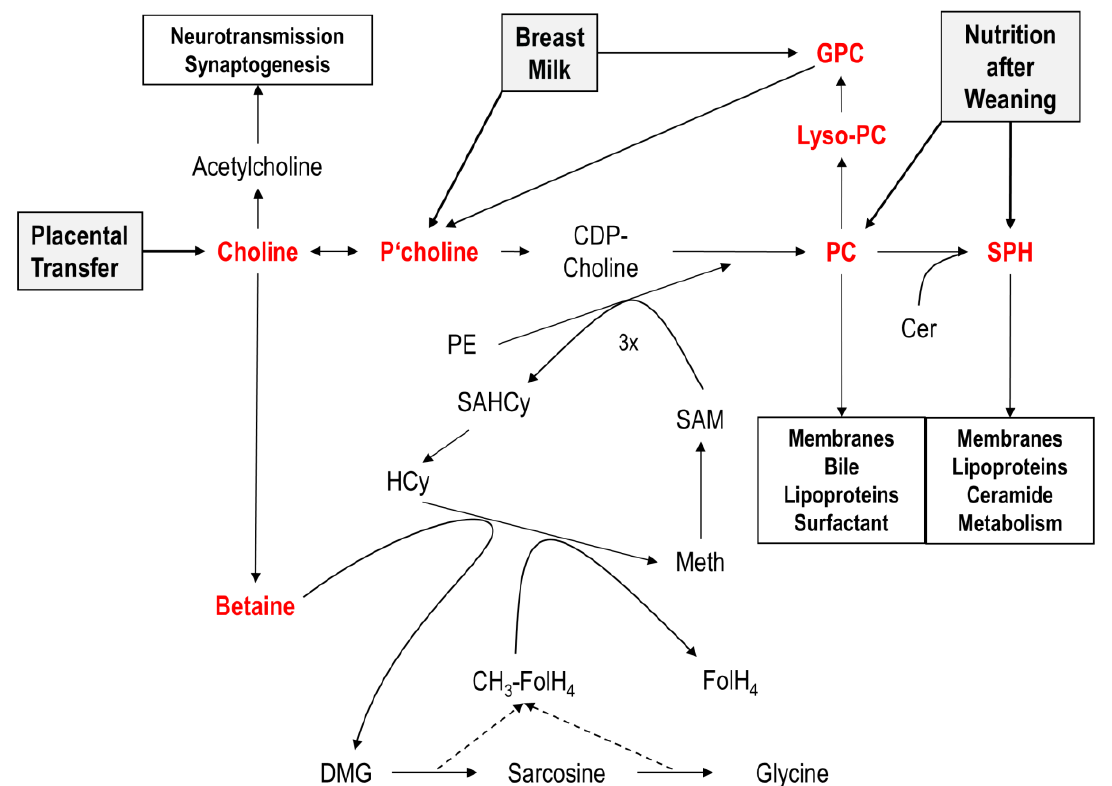
Figure 1. Choline and its individual metabolites in the body and in human nutrition. Graph shows that choline is both substrate for de novo PC synthesis as well as—via betaine—a source of methyl groups/one-carbon units for methionine formation and methylations including endogenous (phosphatidyl)choline (PC) formation. Abbreviations: CDP—choline,